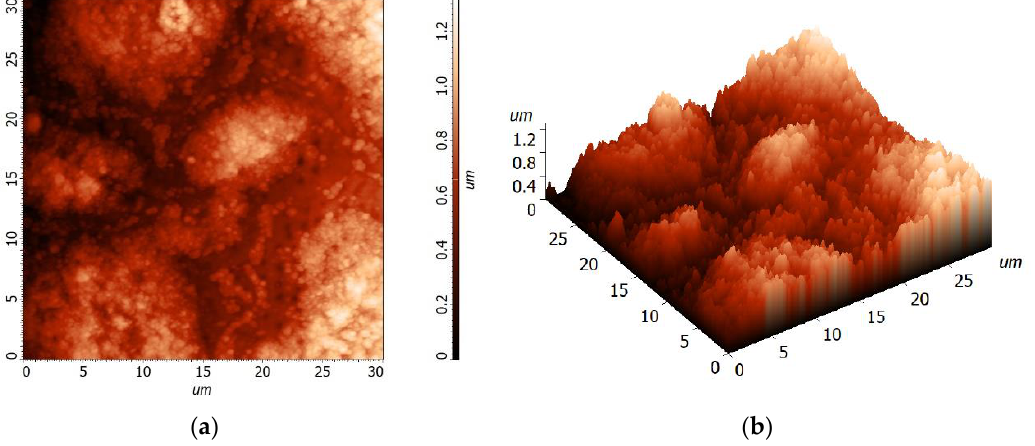
Figure 4. ( a ) 2D topography and ( b ) 3D topography of the “upgraded” ( x = 5-4-3) BST thin film deposited on the stainless-steel substrate by the sol-gel method, followed by spin-coating deposition.